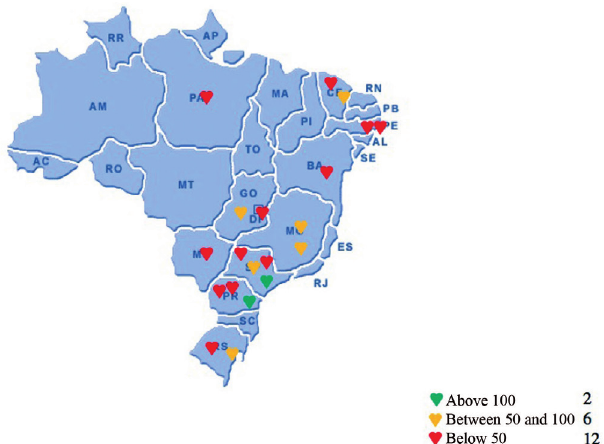
Figure 2 - Distribution of the top 20 hospitals operating patients between 1 month and <1 year